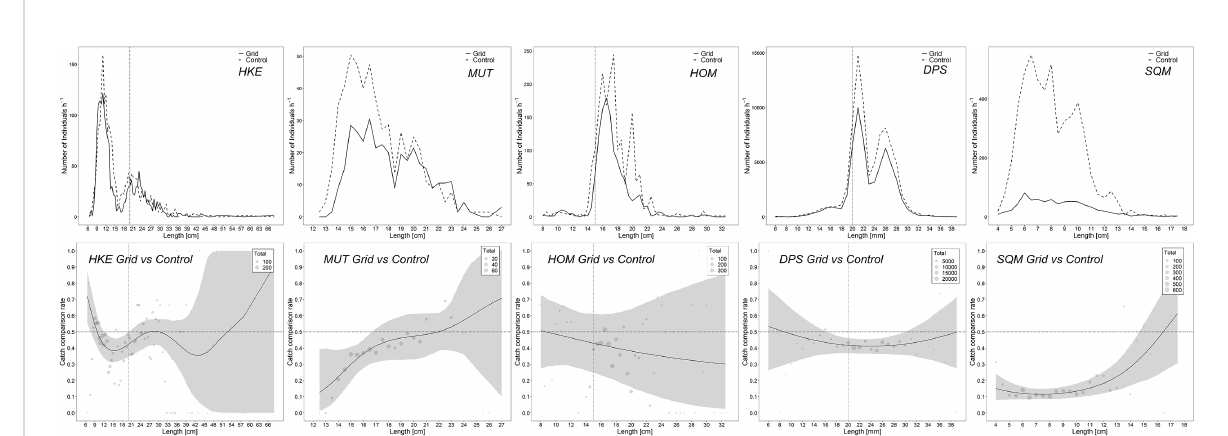
FIGURE 8 Length frequency distributions (above) and modelled catch comparison rates (below) of the GRID and the CTRL. HKE: M. merluccius ; MUT: M. barbatus ; HOM: T. trachurus ; DPS: P. longirostris ; SQM: I. coindetii . Black dotted vertical lines correspond to the MCRS of each species, if any. In the catch comparison graphs, the point-dashed horizontal line at 0.5 represents the point at which both gears have equal catch rates. The solid black line corresponds to the modelled catch comparison while the grey area is its 95% con fi dence interval. Dots corresponds to the individual proportions retained and the size is proportional to the total individual of each size